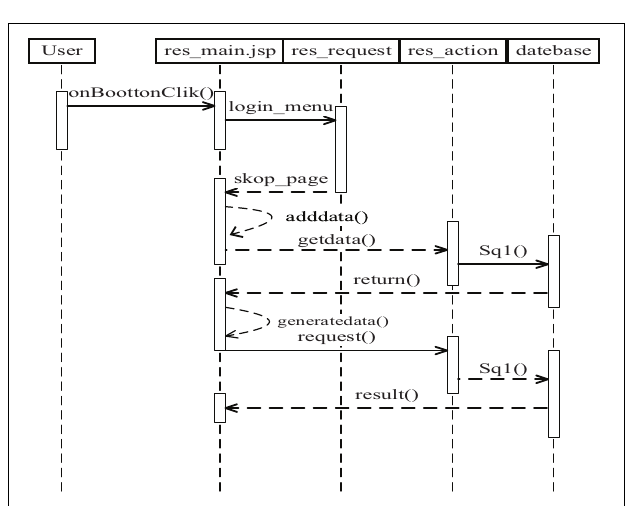
FIGURE 2 | Video upload function timing